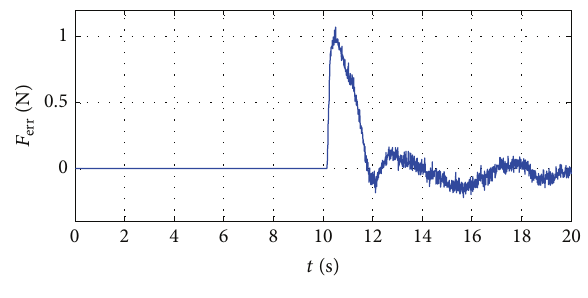
Figure 10: Force tracking error.